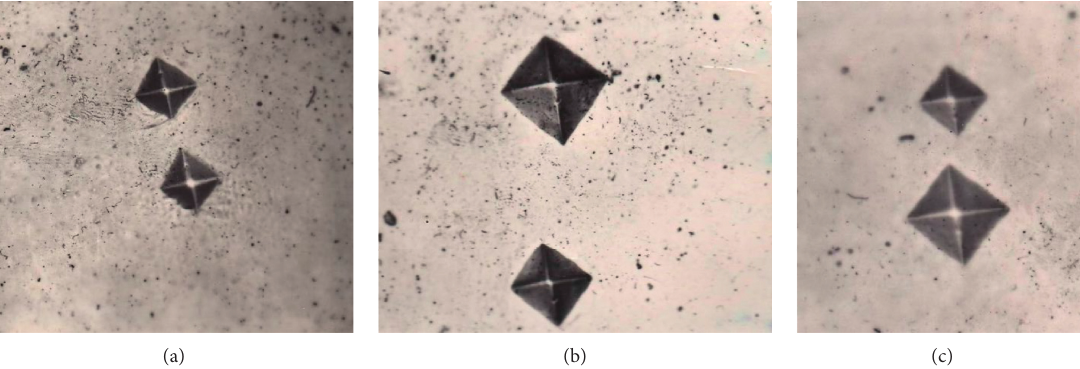
Figure 2: The example of the deposited samples surface microstructure of groups II (a), III (b), and B (c) with applied reference points ( × 500). Table 5: Experimental data characterizing the microplastic deformation of the deposited samples of steel C25 in the normalized state (group A). Deformation Deformation rms deviation σ i (MPa)